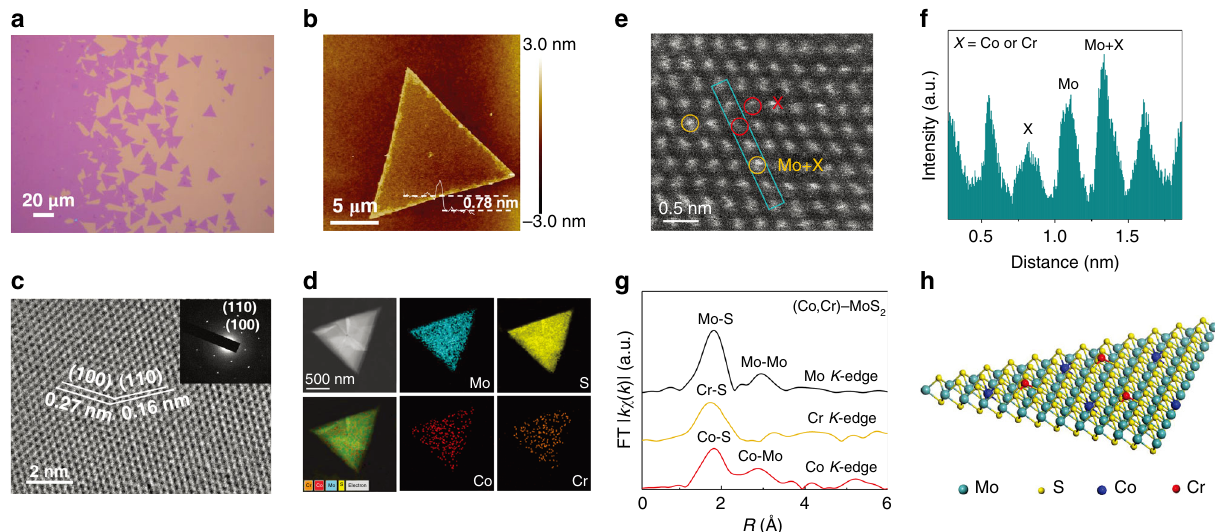
Fig. 2 Characterization of the morphology and the occupation sites of the incorporated ions. a Optical image of as-prepared (Co, Cr)-MoS 2 monolayer on 300 nm SiO 2 /Si substrates prepared by CVD. b AFM image, c HRTEM image, d EDX elemental mapping images, e HAADF-STEM image, and f the intensity spectra of the selected area of (Co, Cr)-MoS 2 monolayer. g The FT curves of the Co, Cr K -edge EXAFS k χ ( k ) functions for (Co, Cr)-MoS 2 monolayer . The Mo K -edge FT curve for MoS 2 bulk reference are also displayed. h The atomic model of the (Co, Cr)-MoS 2